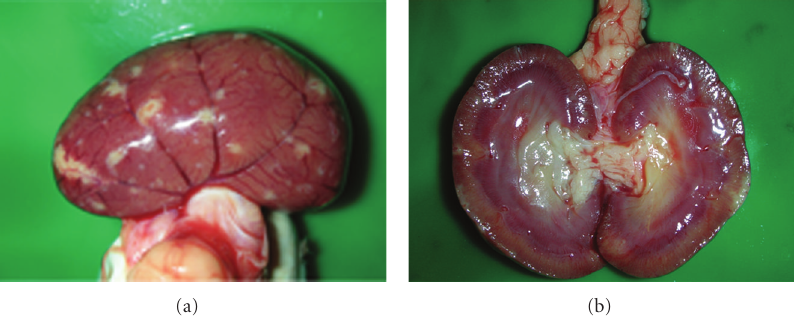
Figure 4: Kidney of a cat with non-e ff usive FIP. Granulomatous lesions can be seen on the capsular surface and in the parenchyma of the kidney.